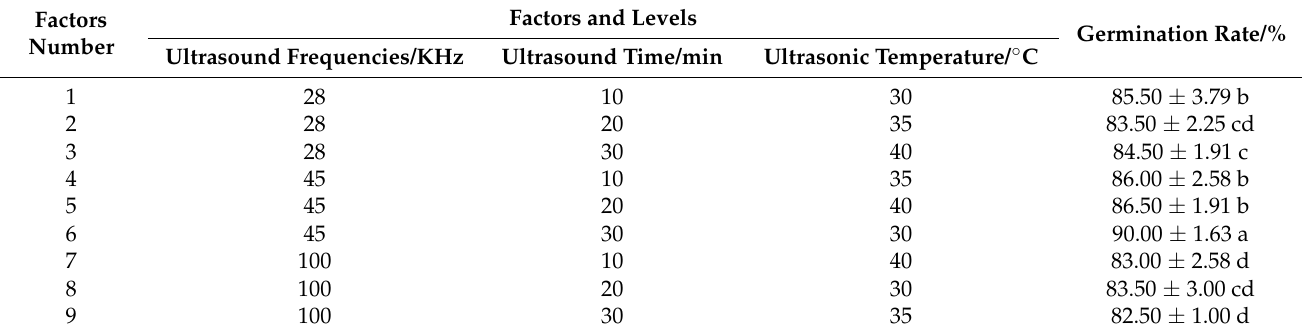
Table 2. Orthogonal experimental table L 9 3 3 and the experimental results for each index.